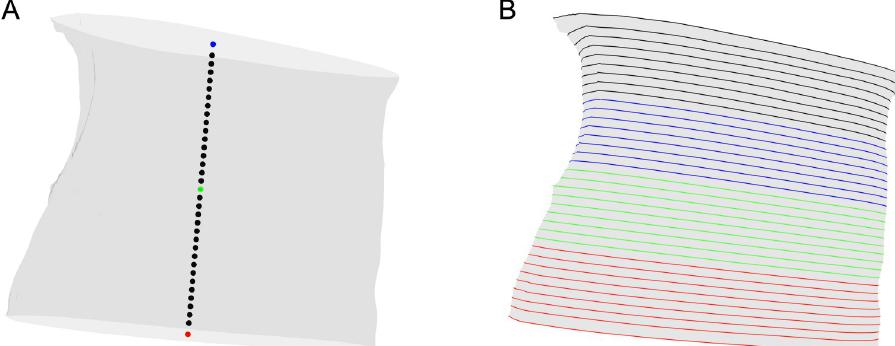
Fig 2. Carpal tunnel cross-sections used to calculate morphology metrics. Panel A shows the centroids of the cross- sections spaced at 0.5 mm increments starting from the midpoint (green) of the vector between the centroids of the proximal (red) and distal (blue) boundaries. Panel B shows the cross-sections of a representative carpal tunnel in neutral posture colour coded by volume quartile, where Q1(proximal) is red, Q2 is green, Q3 is blue, and Q4 (distal) is